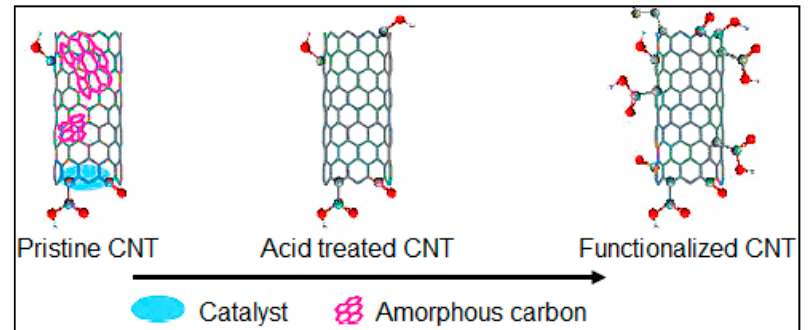
Figure 5. Illustration of the removal of catalyst and amorphous carbon from pristine CNTs through acid treatment and functionalized through APTS treatment.